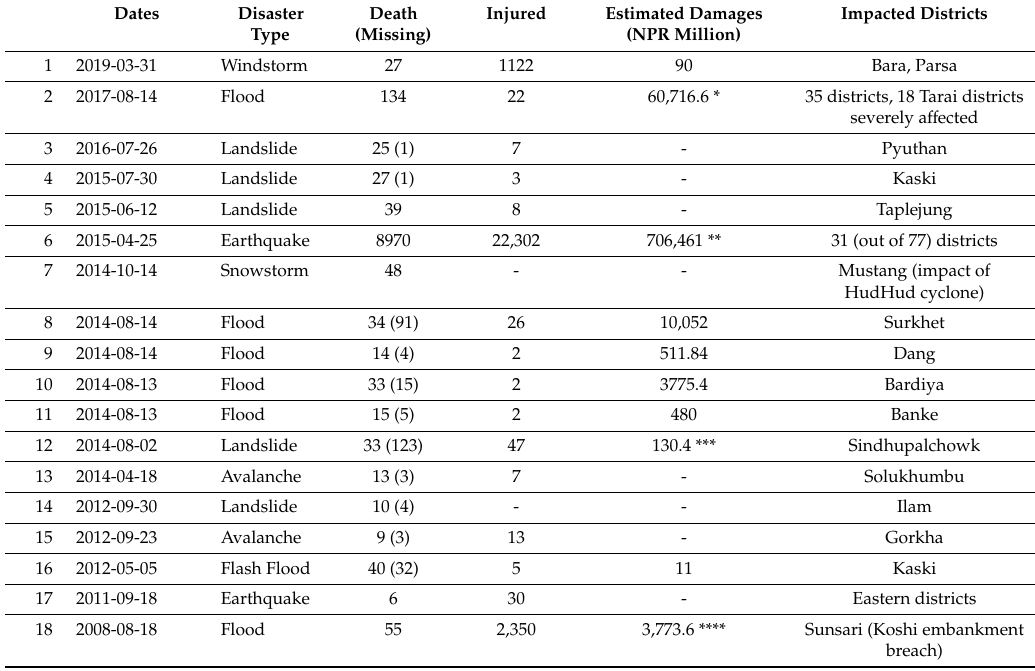
Table 1. Major disasters that occurred in Nepal from 2008 to